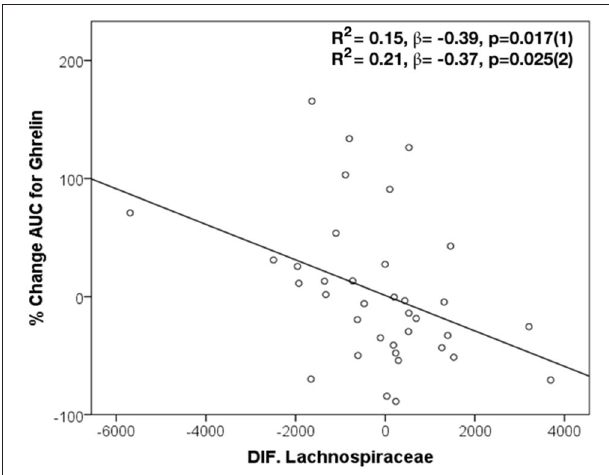
FIGURE 3 | Changes in Lachnospiraceae in the prediction of modifications in AUC for ghrelin after H. pylori eradication treatment. Dependent variable: ghrelin AUC. Model (1): Linear Univariate regression model. Model (2): Linear multivariate regression model adjusted by age, sex, and BMI.